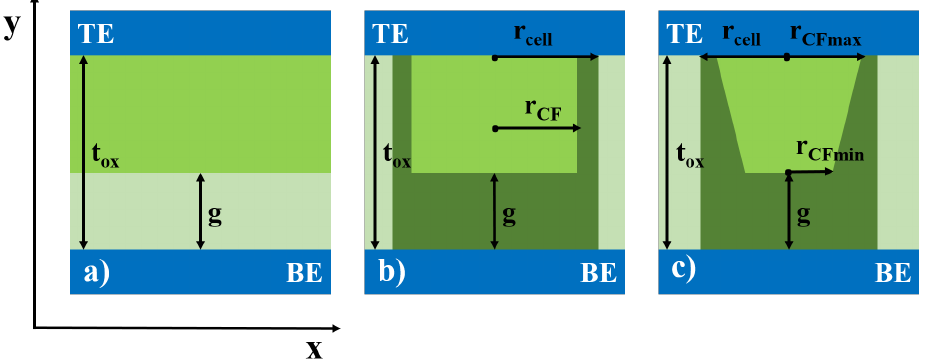
Figure 1. Three-dimensional geometrical representation of ( a ) the Stanford-PKU model, ( b ) the UGR-VCMCF model and ( c ) the